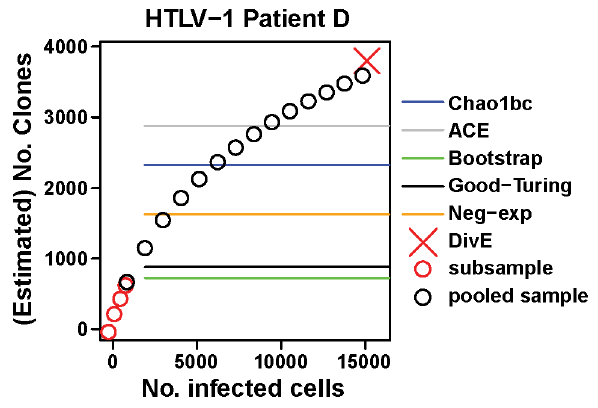
Figure 5. Existing estimators underestimate diversity in HTLV- 1 infection. For HTLV-1 Patient D, three samples are pooled. Rarefaction curves from the pooled sample (black circles) and a subsample (red circles) are shown. Chao1bc, ACE, Bootstrap, Good- Turing and negative exponential estimates (blue, grey, green, black, and orange lines respectively) from the subsample, and DivE estimates (red cross) from the same subsample are plotted. Existing estimators produce a single estimate of diversity, and so their estimates are shown as lines. The diversity in the blood must be at least as great as that observed by pooling the samples. All existing estimators estimate the total diversity to be less than that observed. Given that the observed diversity is likely to be a small fraction of the total diversity this represents a considerable error. We used DivE to produce two estimates: the diversity in the pooled sample (i.e. in 15000 cells, red cross) and the total diversity of the blood. DivE accurately estimates the pooled sample species richness from the subsample, but also predicts higher values of species richness in the blood, consistent with the unseen clones implied by the pooled rarefaction curve. See Figure S3 for further examples.